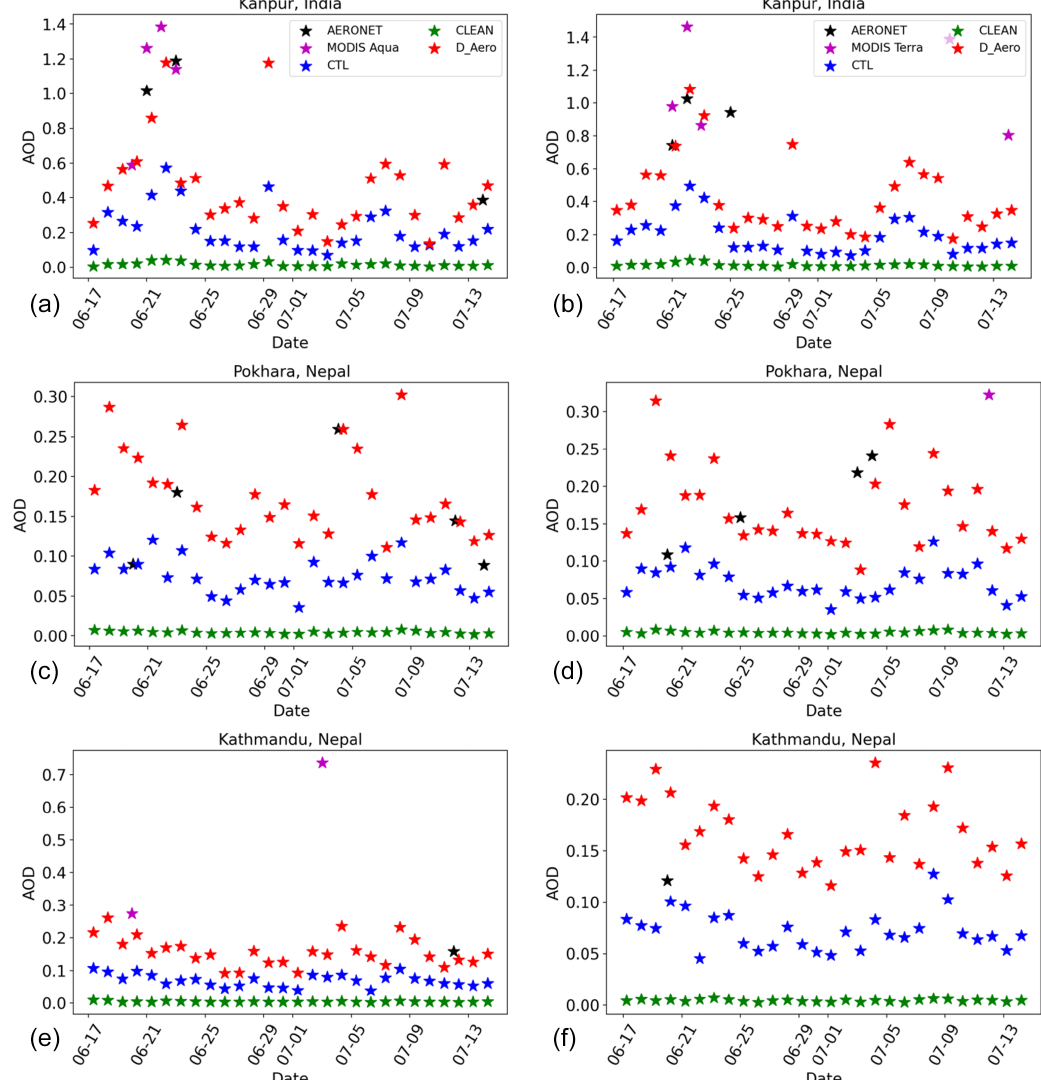
Figure 3. The simulated AERONET and MODIS Aqua (a, c, e) and Terra (b, d, f) AOD at three AERONET stations (Kanpur, Pokhara, and Kathmandu; see Fig. 1a for